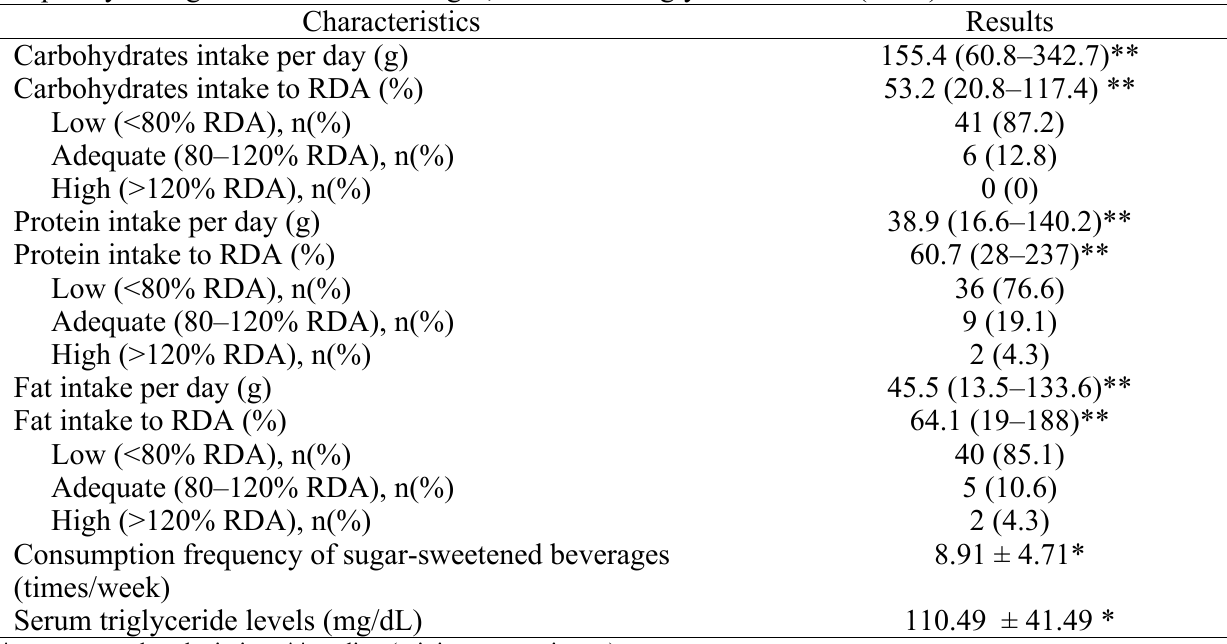
Table 2 Characteristic of subjects based on intake of carbohydrates, fats, proteins, consumption frequency of sugar-sweetened beverages, and serum triglyceride levels